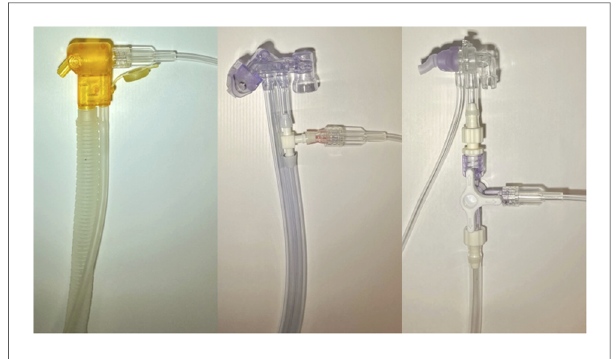
FIGURE 3 Connection of the O 2 -FS to CPAP interfaces. From left: Medijet, Infant Flow, and Infant Flow Low Pressure.